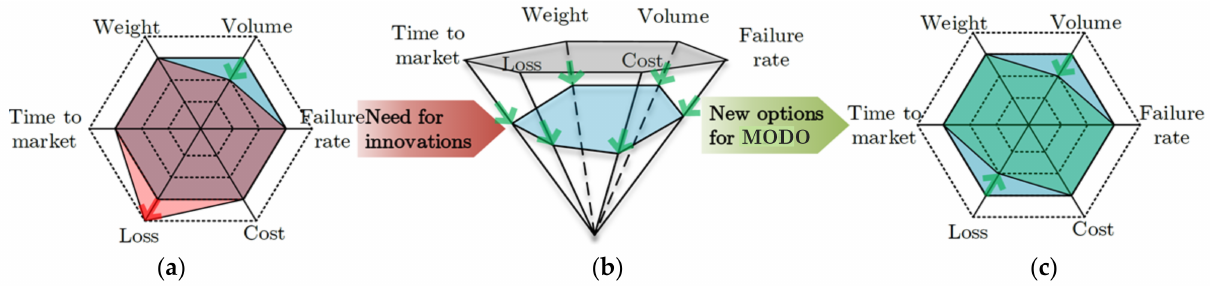
Figure 4. Power electronics performance trends: ( a ) achievable performance using state-of-the-art technology (blue) and performance limits due to physical barriers (red), ( b ) improvements over time, ( c ) expected performance